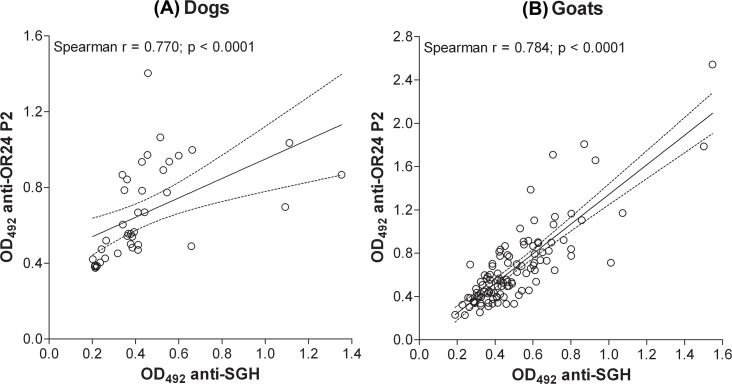
Correlation analyses between anti-P. orientalis IgG detected by SGH and by peptide OR24 P2 in ELISAs.For dogs (n = 40) and goats (n = 109) the peptide with the highest statistical values is displayed. Correlation coefficients and p-values from Spearman-Rank analysis are indicated.